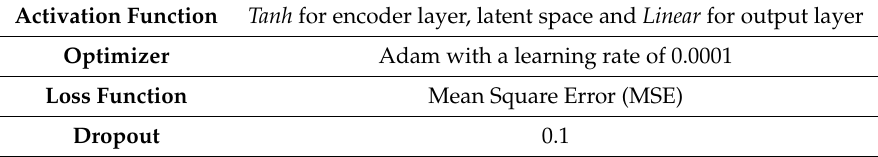
Table 2. Parameters of the autoencoder